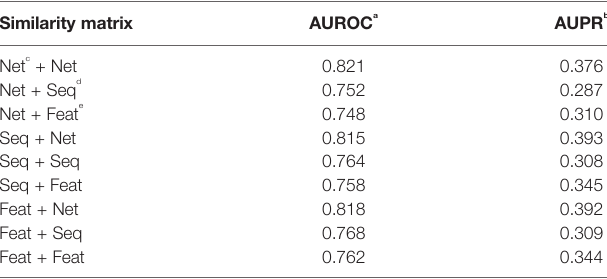
TABLE 1 | AUROC and AUPR of nine similarity combinations. Similarity